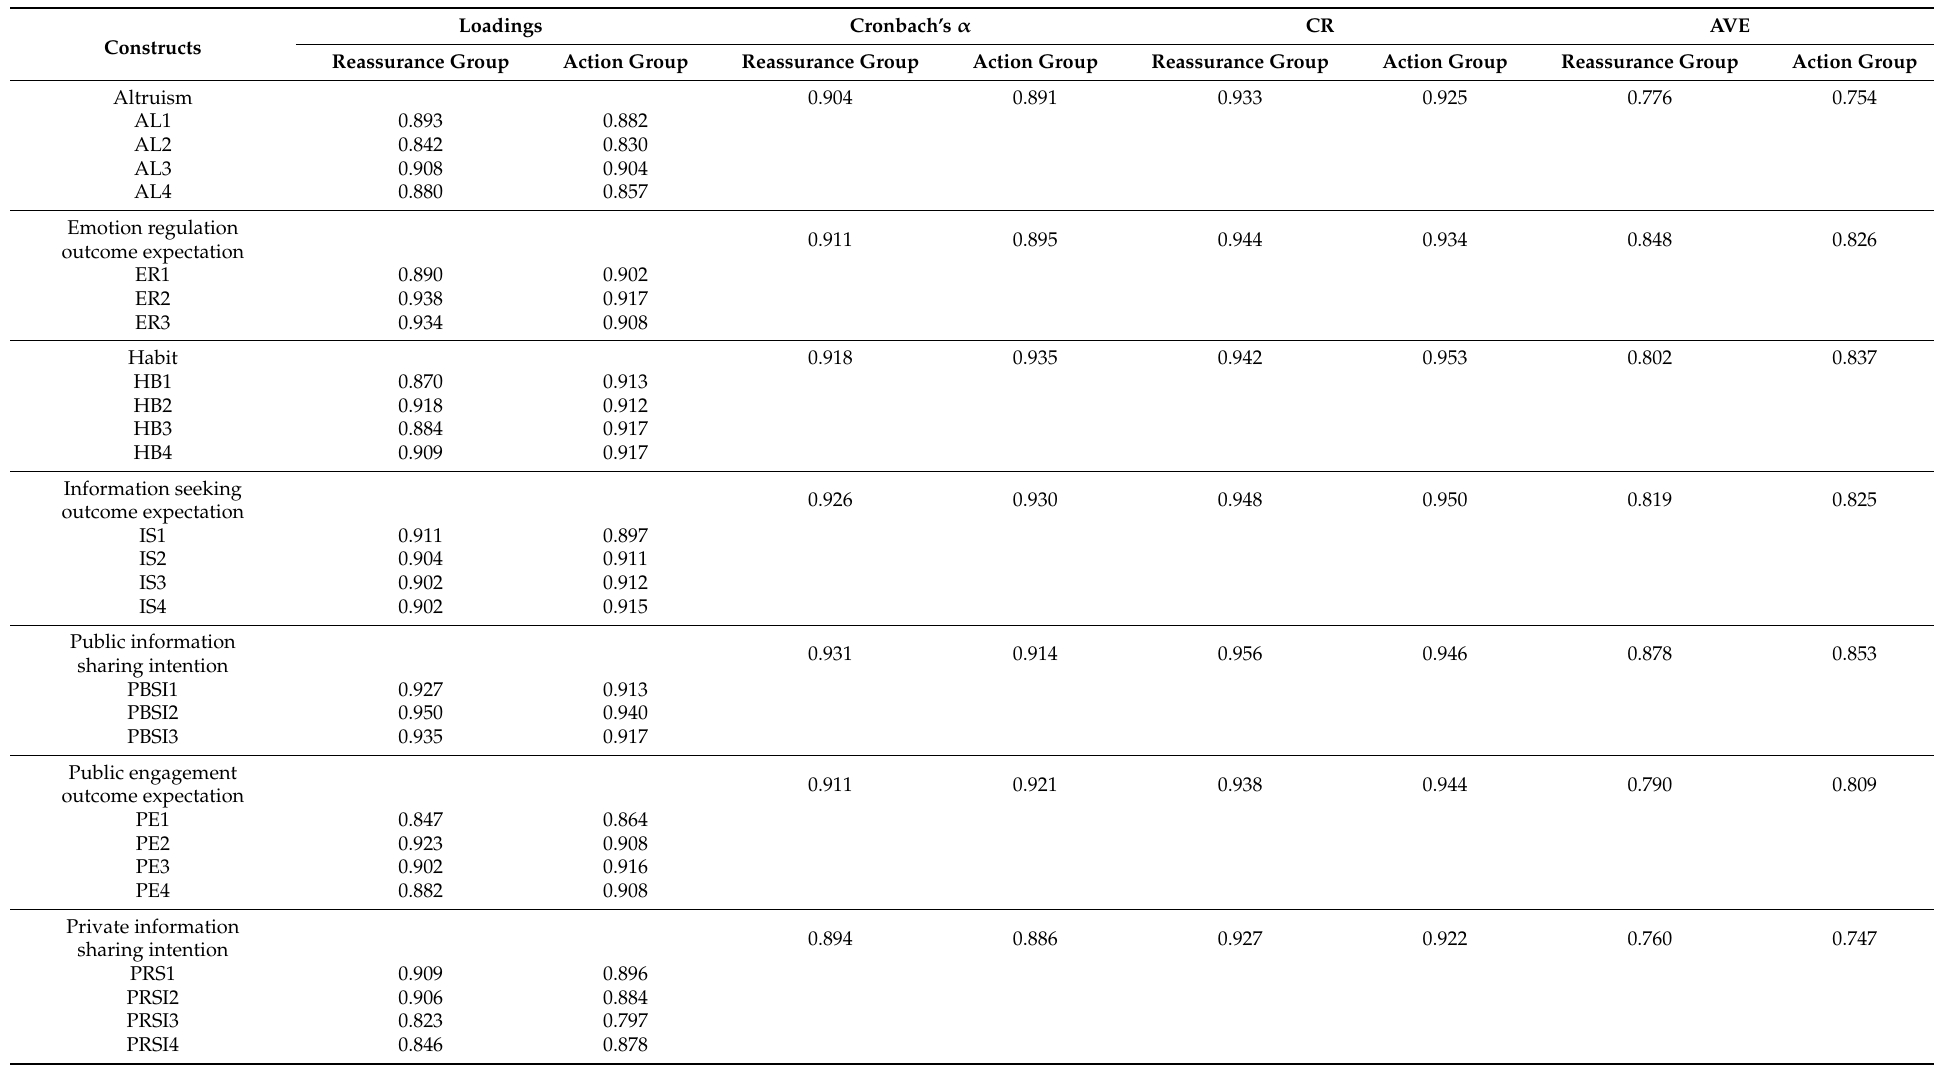
Table 3. Results for the measurement